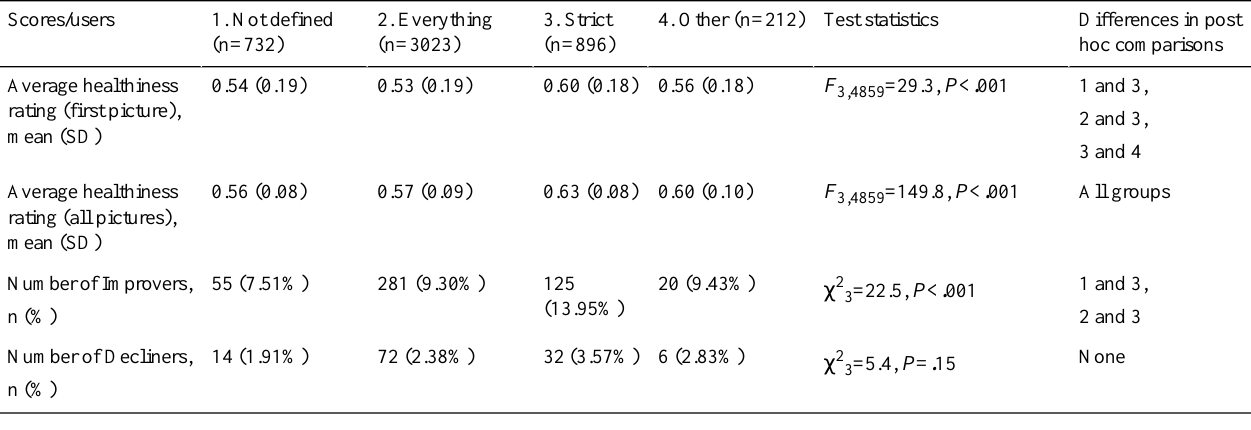
Table 8. Average healthiness rating and number of users (Actives) that had a significant linear coefficient in their healthiness rating in each dietary preference